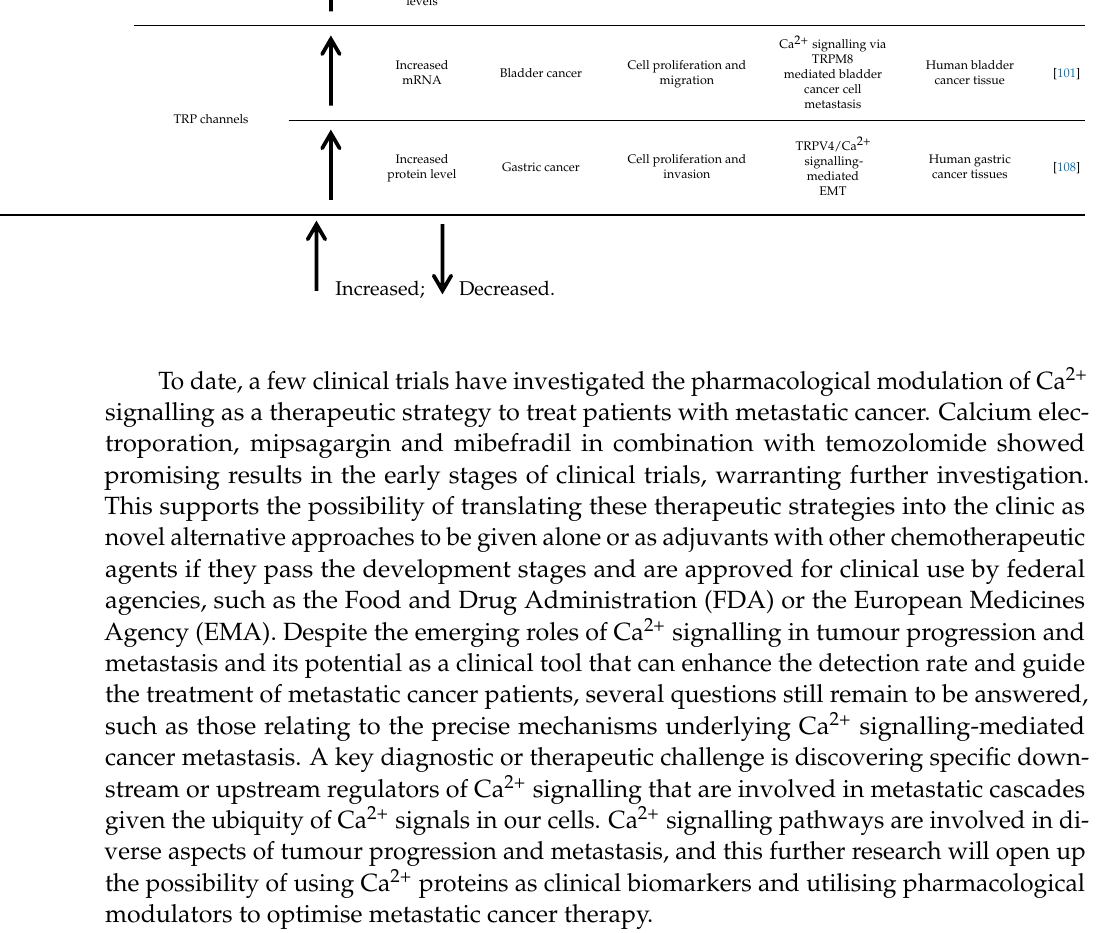
Table 1. Some experimental evidence supporting Ca +2 signalling-mediated cancer